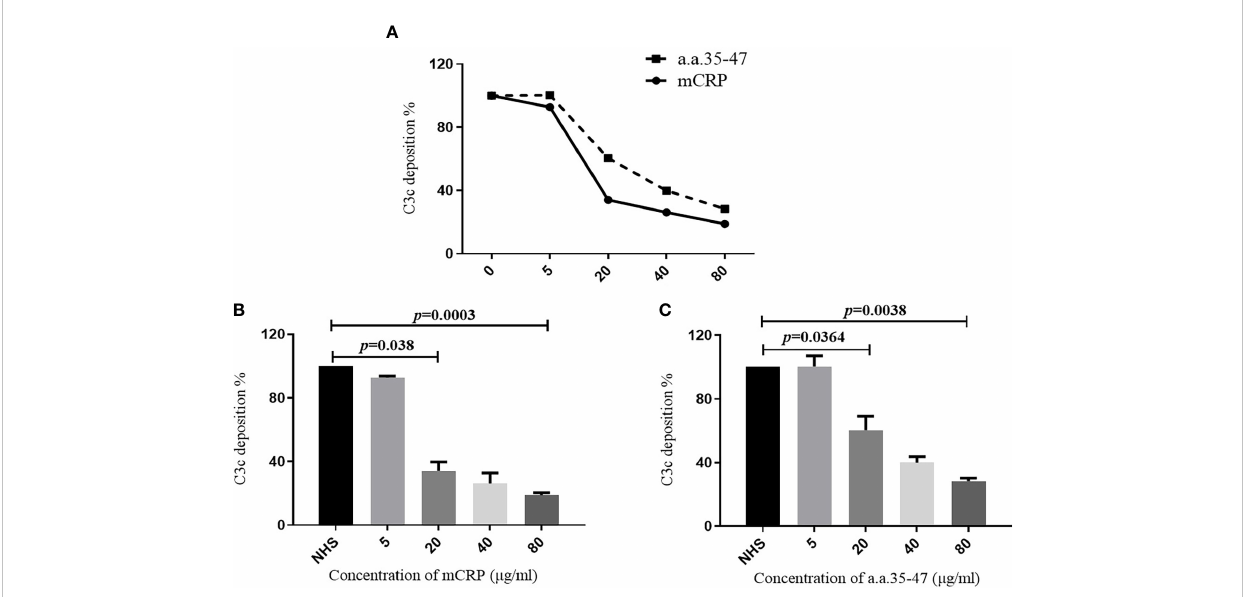
SUPPLEMENTARY FIGURE 1 The correlation analysis of levels of anti-C1qA08 antibodies and